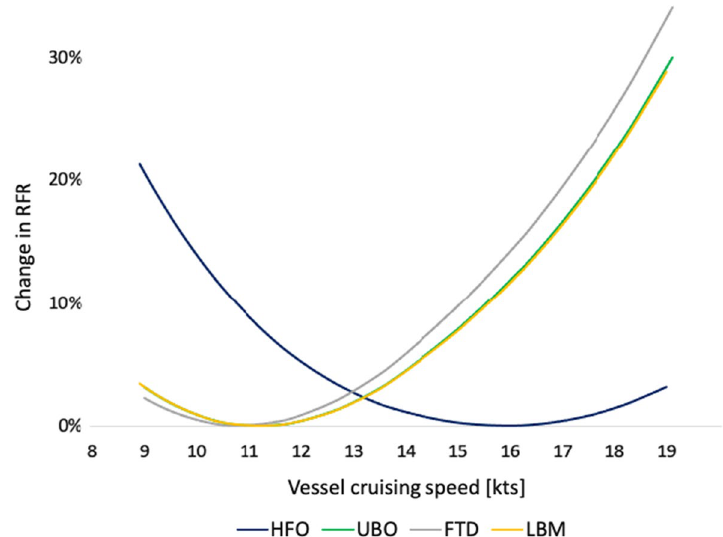
Fig. 5 Sensitivity analysis on vessel speed for HFO, UBO, FTD and LBM under the average, 2020, no regulation